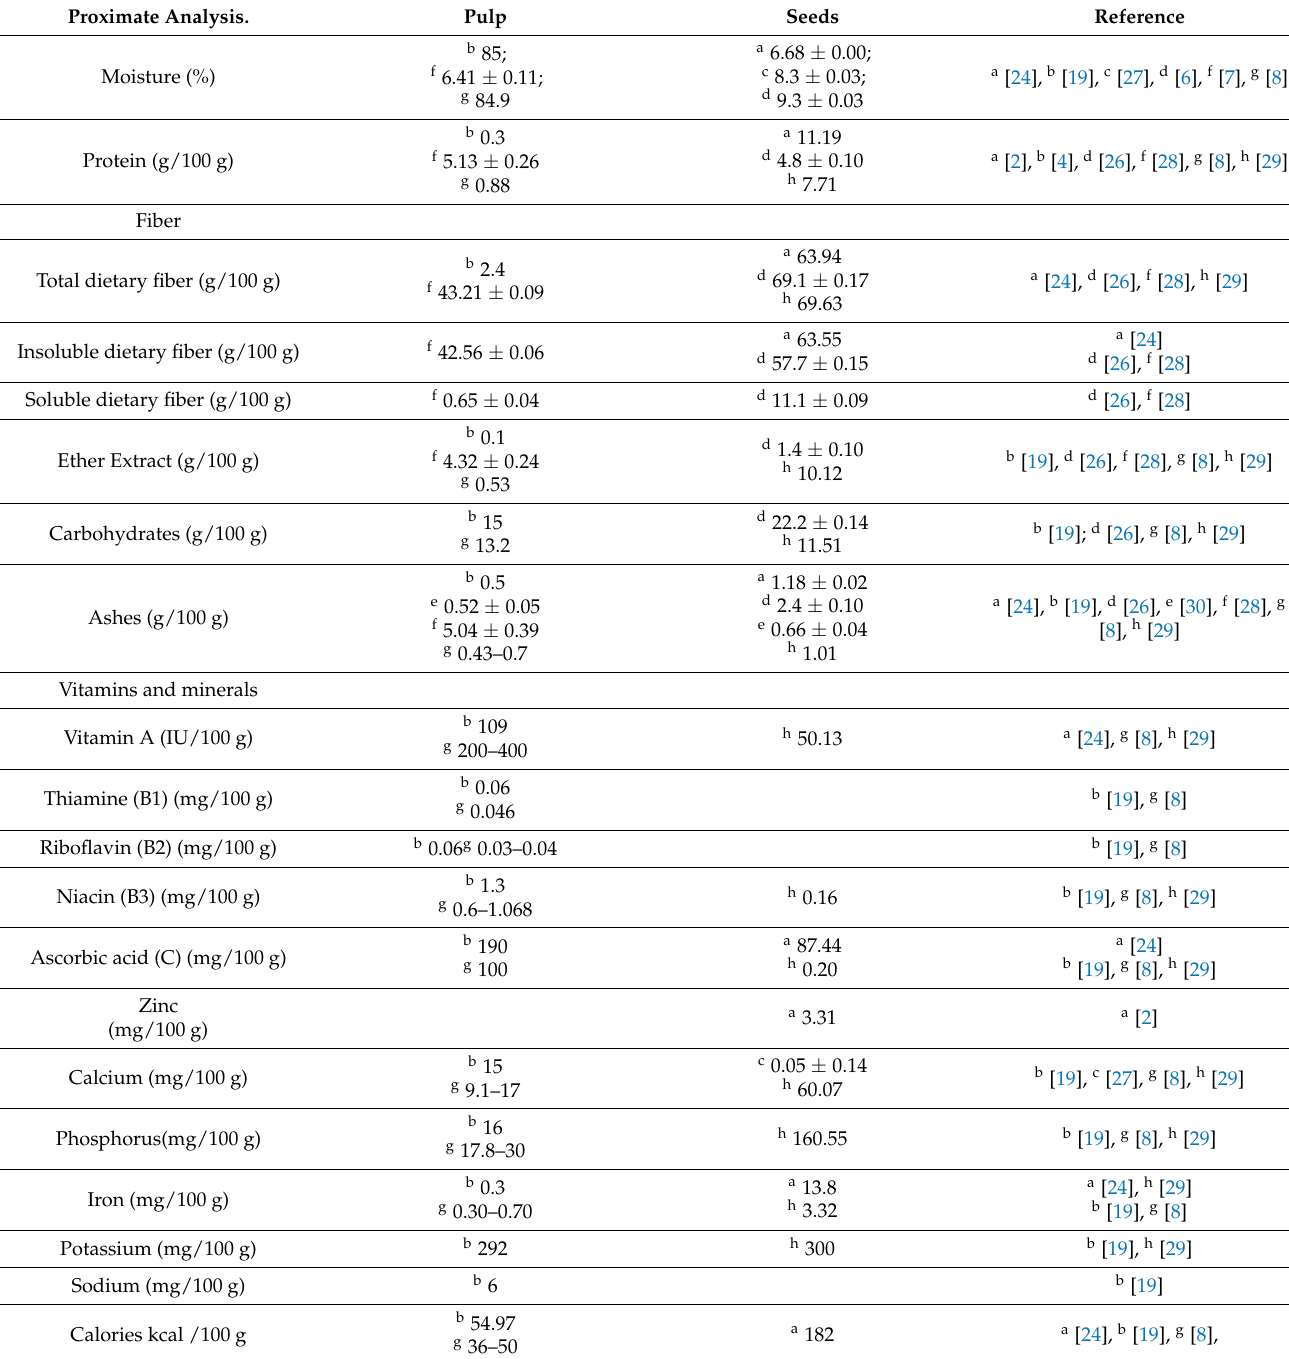
Table 1. Physicochemical composition of pulp and seeds of Psidium guajava